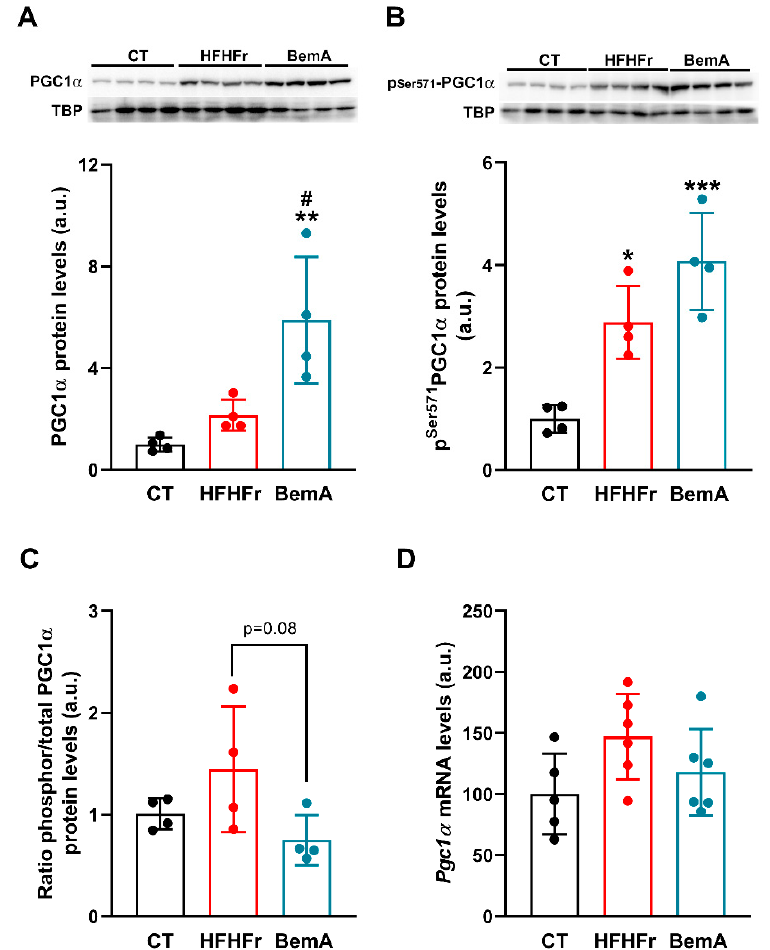
Figure 6. Effect of HFHFr supplementation and BemA treatment on Sprague-Dawley female rats’ liver expression of PGC1 α . Bar plots show total ( A ) and phosphor-Ser 571 ( B ) liver protein levels from control (CT), high-fat high-fructose (HFHFr), and bempedoic acid (BemA)-treated rats. The results are expressed as the mean ± SD of four pooled samples, obtained by mixing equal amounts of tissue from two rats, for each condition. On the upper side of the figures, representative western blot bands corresponding to the three different study groups are shown; ( C ) bar plots show the ratio of phosphor-Ser 571 to total PGC1 α protein levels for each pooled sample shown in Figure 6A,B; ( D ) bar plots show the relative mRNA levels of the pgc1 α gene as mean ± SD, as well as individual values from 5–6 tissue samples, corresponding to the three experimental groups studied. a.u.: arbitrary units. Data were analyzed by one-way ANOVA followed by Tukey’s post-hoc test. * p < 0.05, ** p < 0.01, *** p < 0.001 vs. CT; # p < 0.05 vs.